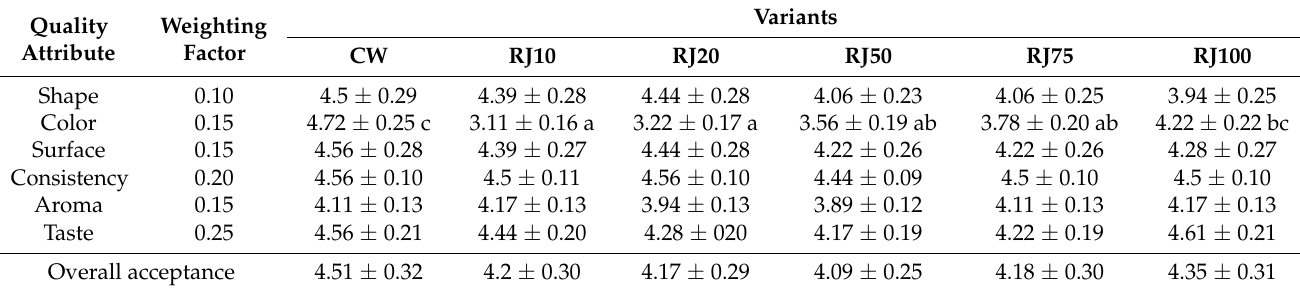
Figure 1. Control wafers (CW) and wafers fortified with raspberry juice (RJ10–RJ100, from 10% to 100% water substitution with raspberry juice, respectively).